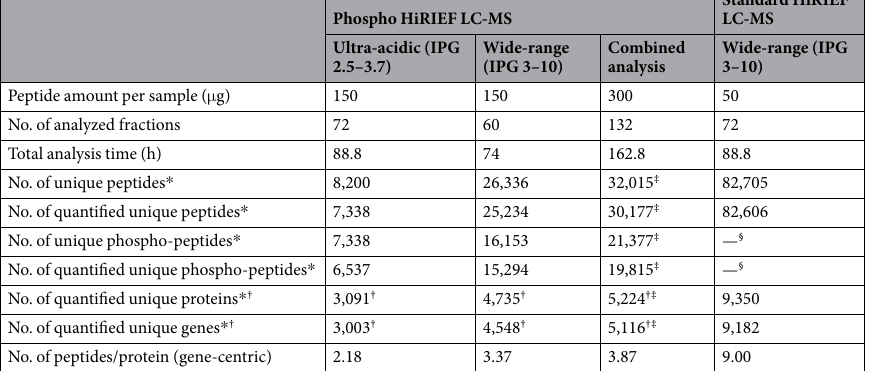
Table 1. Analysis conditions and number of identifications for Phospho HiRIEF LC-MS and Standard HiRIEF LC-MS. The column “Combined analysis” recapitulates the overall results of the Phospho HiRIEF LC-MS approach, obtained by employing both immobilized pH gradient (IPG) strips, pH range 2.5–3.7 and 3–10. * Peptides are defined as unique by sequence and number of phosphorylations; proteins and genes are defined as unique by Uniprot-ID and Gene symbol, respectively. † For Phospho HiRIEF LC-MS analysis the reported numbers refer only to proteins found to carry phosphorylated amino acids, and their corresponding genes. ‡ Number of unique identifications obtained across both IPG strips. § Phosphorylation was not included as dynamic modification when searching data generated by the Standard LC-MS